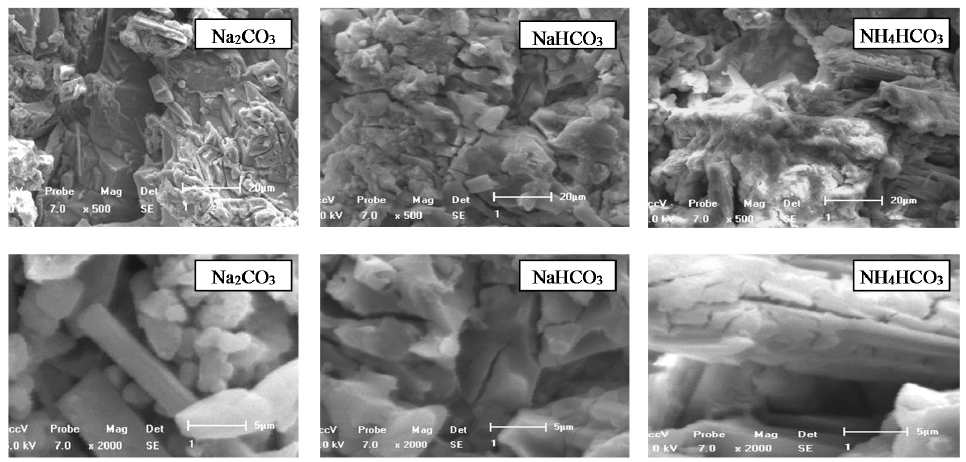
Figure 5. SEM images of the surface of calcium metavanadate under different leaching conditions (60 °C, 30 min).